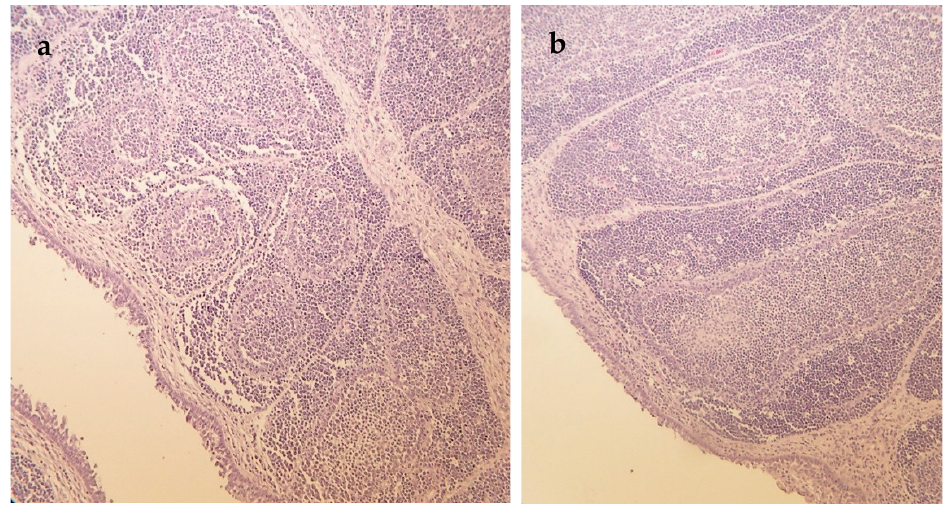
Figure 2. Hematoxylin and eosin-stained sections of the bursa of Fabricius of ducks ( a ) Bursa of Fabricius section of a duck fed mycotoxin contaminated control diet showing mildly decreased lym- phocyte counts (day 14), 200× magnification; ( b ) Bursa of Fabricius section of a duck fed mycotoxin contaminated diet supplemented with milk thistle seed showing normal lymphocyte counts (day 14), 200× magnification.